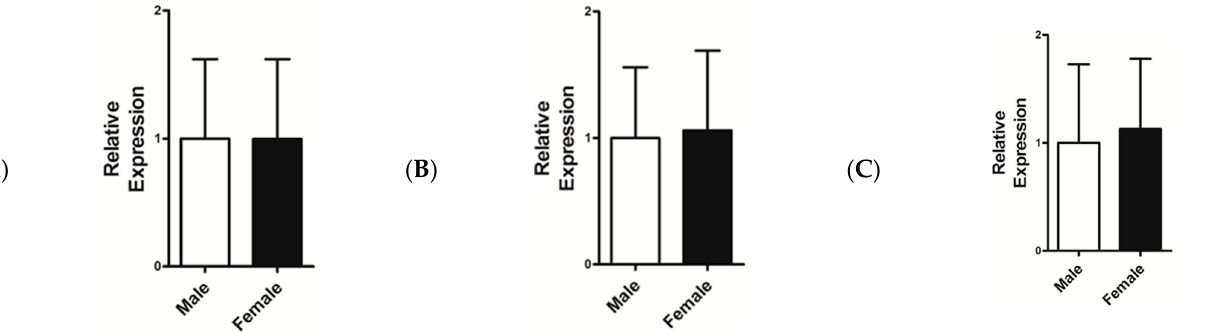
Figure 6. Relative mRNA expression of genes IGF-1 ( A ), FGF5 ( B ), and KAP 1.4 ( C ) in ear skin tissue of the Northwestern Tibetan cashmere goat by sex. Data are mean ± SD from three independent experiments ( p > 0.05).